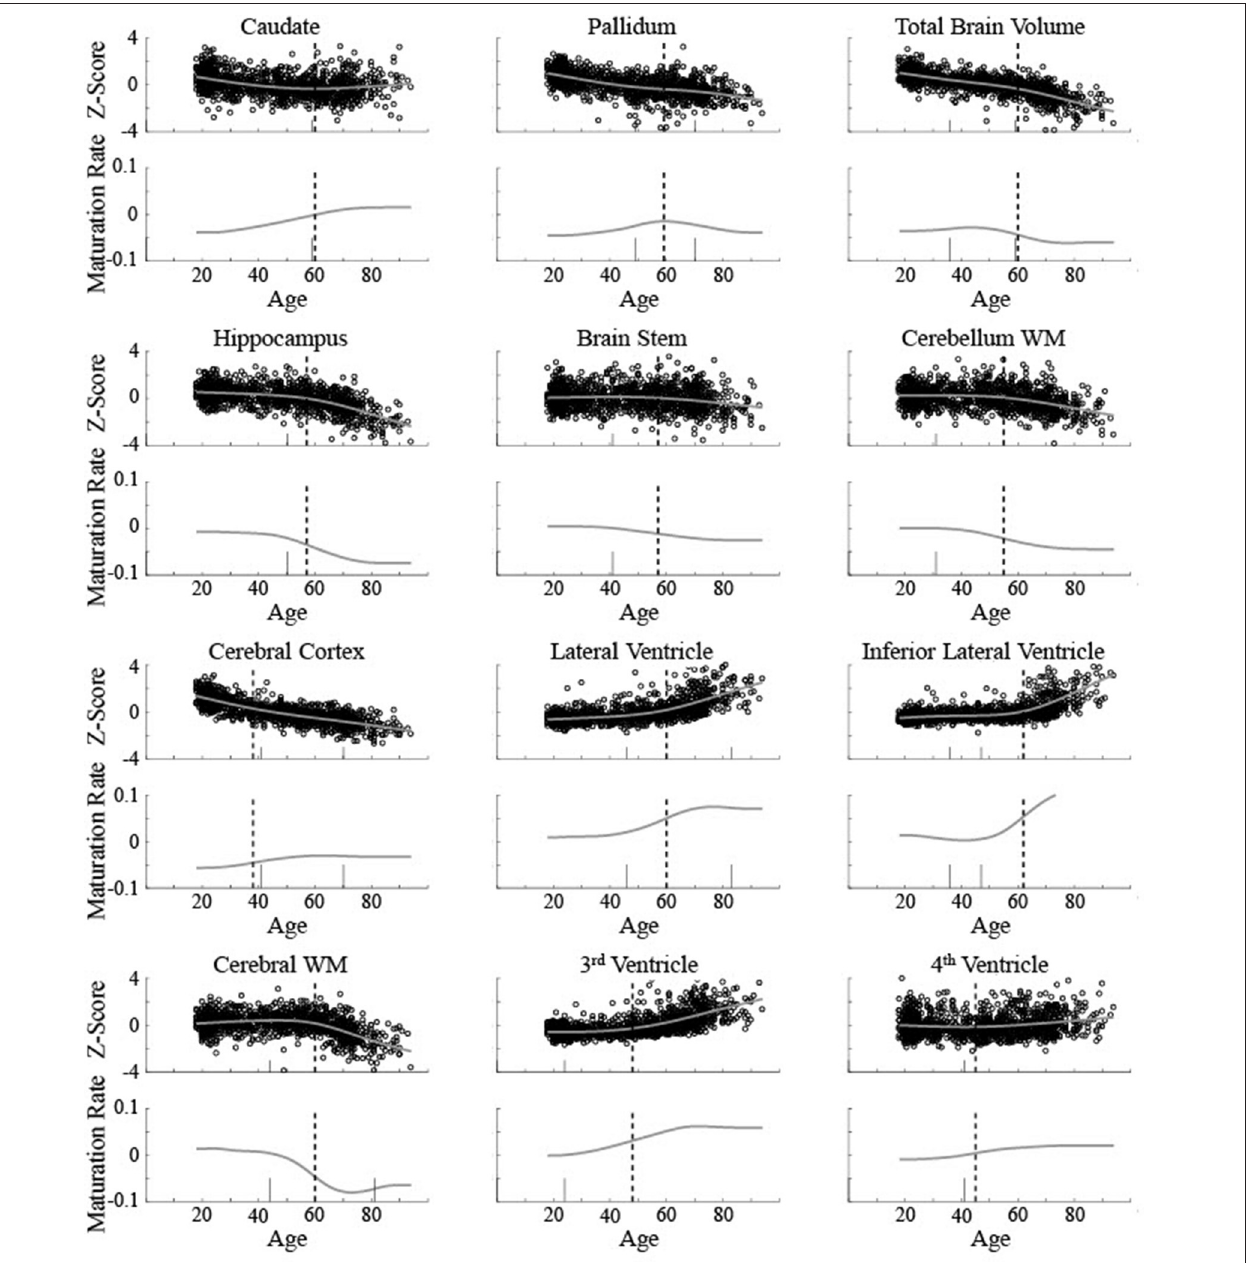
FIGURE 9 | Biological data for 12 brain measurements (circles) is shown along with the smoothing spline curve fit (smooth line) for all measurements classified as non-linear curve types. Top rows show volume (z-score) and the bottom rows show the calculated instantaneous slope (maturation rate: spline fit. The upper left measurement (caudate nucleus) was classified as Curve Type 1, the upper middle (pallidum) was classified as Curve Type 2, with the remaining classified as Curve Type 3. Dotted vertical lines show the critical age guess based on the classification procedure. Short solid vertical lines show the critical ages reported in Fjell et al.